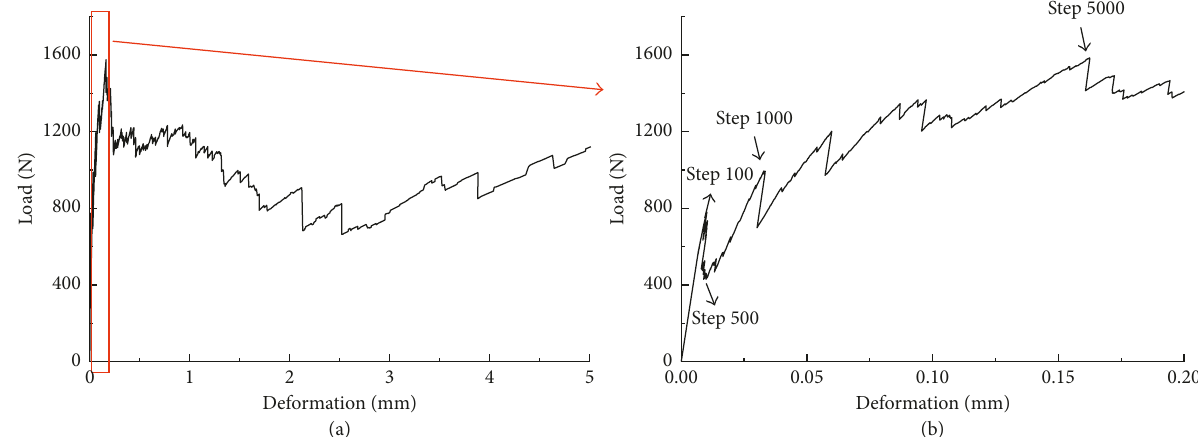
Figure 7: Simulated load-deformation curve of UHPFRC. (a) Full load-deformation curve. (b) Load-deformation curve before deformation reaches